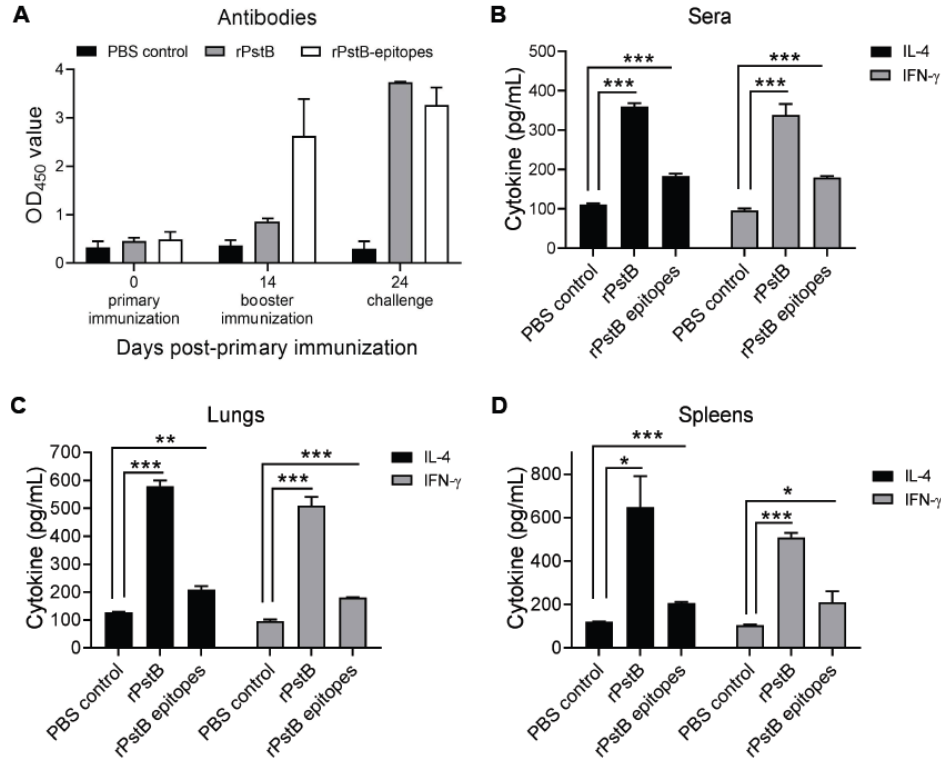
Figure 4. Antibodies and cytokines in immunized mice. ( A ) The levels of antibodies specific to rPstB or rPstB epitopes in sera collected before primary immunization (0 days post-primary immunization), after booster immunization (14 days post-primary immunization), and before challenge (24 days post-primary immunization). The levels of IL-4 and IFN- γ in sera ( B ), lungs ( C ), and spleens ( D ) collected at 24 days post-primary immunization were examined by ELISA. Statistically significant differences compared with the PBS control group are indicated by asterisks (* p < 0.05; ** p < 0.01; *** p < 0.001).